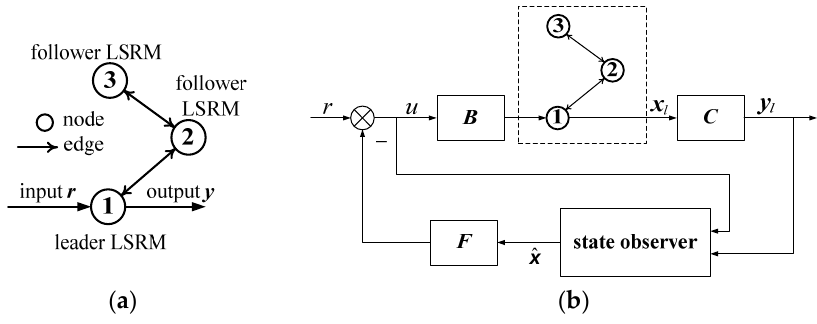
Figure 2. ( a ) Network topology ( b ) block diagram of the proposed control scheme.